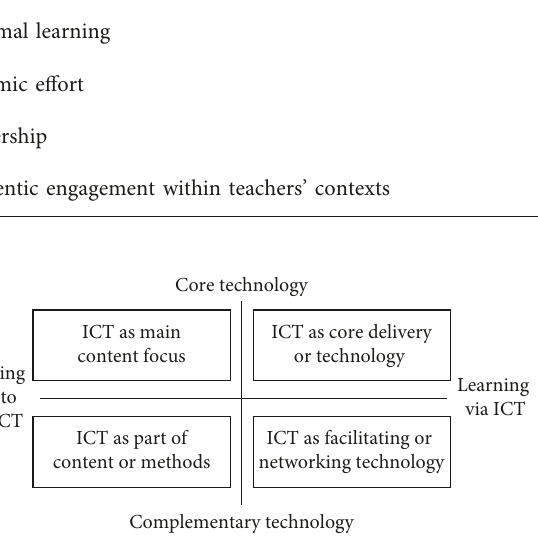
Figure 5: ICT-pedagogy integration in teacher